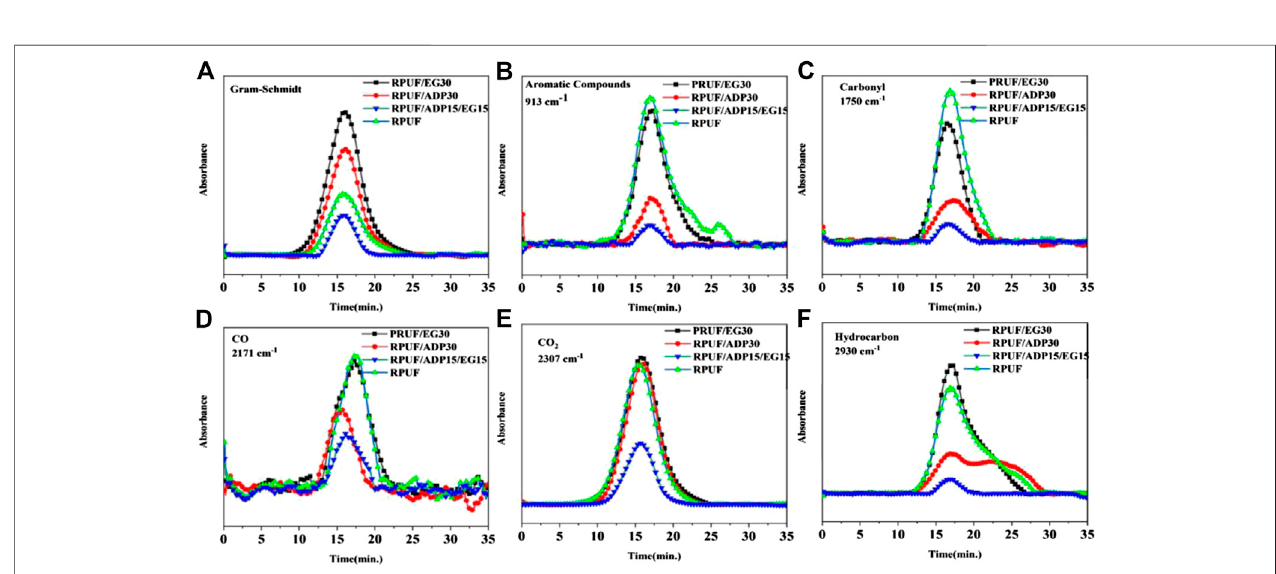
FIGURE5| AbsorbanceofgaseousproductsofRPUFandFR-RUUFcompositesversustime: (A) Gram-schmidt; (B) aromaticcompounds; (C) carbonyl; (D) CO; (E) CO 2 ; (F) hydrocarbon.